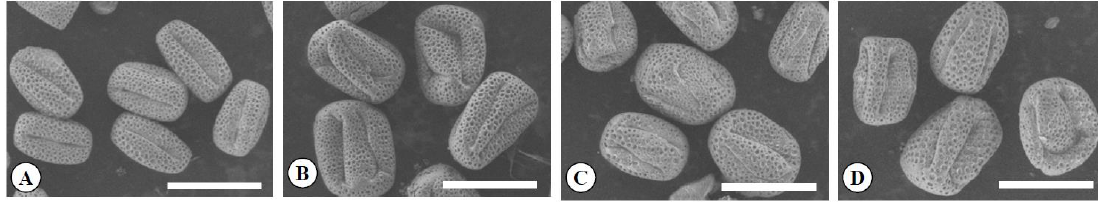
Figure 6. Scanning electron micrographs of pollen grains in the diploid ( A ), the tetraploid ( B ), the Yubeni ( C ), and the chimera ( D ) of the Meiwa kumquat. Bars = 30 μm.